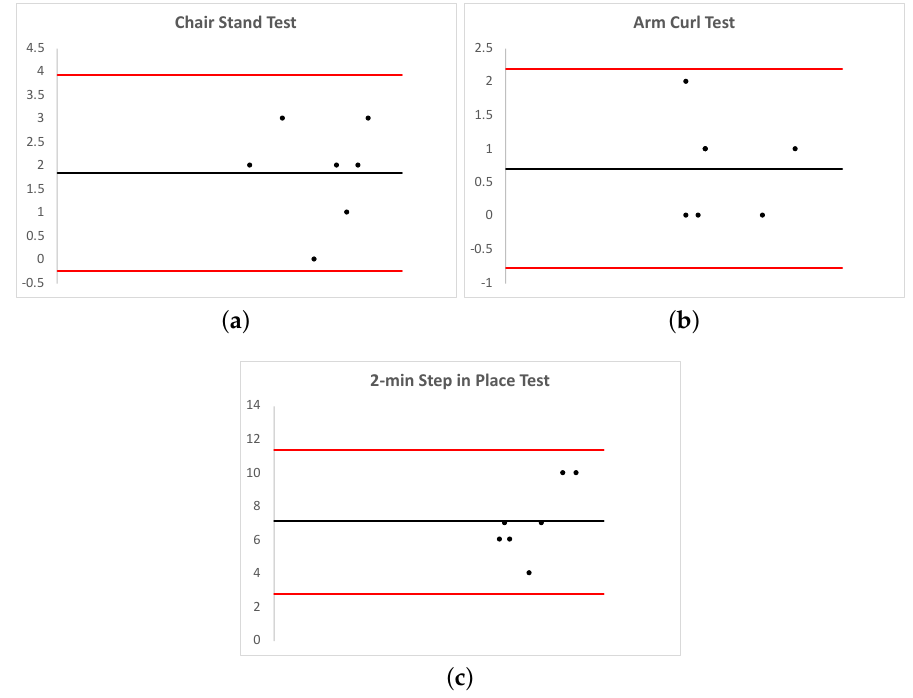
Figure 10. Agreement analysis between SFT and m-SFT assessment through Bland-Altman plots: ( a ) Chair Stand Test, ( b ) Arm Curl Test, and ( c ) 2-min Step in Place Test. The mean of differences ( ¯ x ) is represented by a black line, while the limits of agreement ( ¯ x ± 1.96 σ X ) are depicted in red.